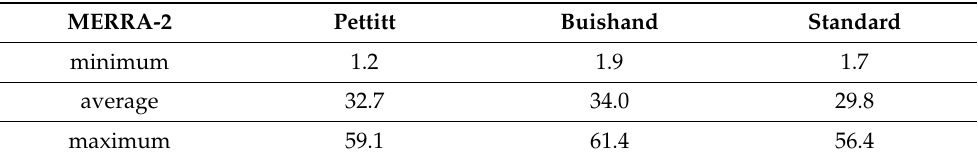
Figure 5. Vertical profile of average (black), minimal (blue) and maximal (red) share of explained discontinuities by the change in 2015 to all discontinuities from all months from MERRA-2 for the Pettitt test ( upper panel ), the Buishand test ( middle panel ) and the Standard Normal Homogeneity test (SNTH, lower panel ). Table 5. Minimal, average, and maximal share of explained discontinuities in percentage by the change in 2004 to all discontinuities from all months from MERRA-2 for the Pettitt test, the Buishand test and the Standard Normal Homogeneity test.